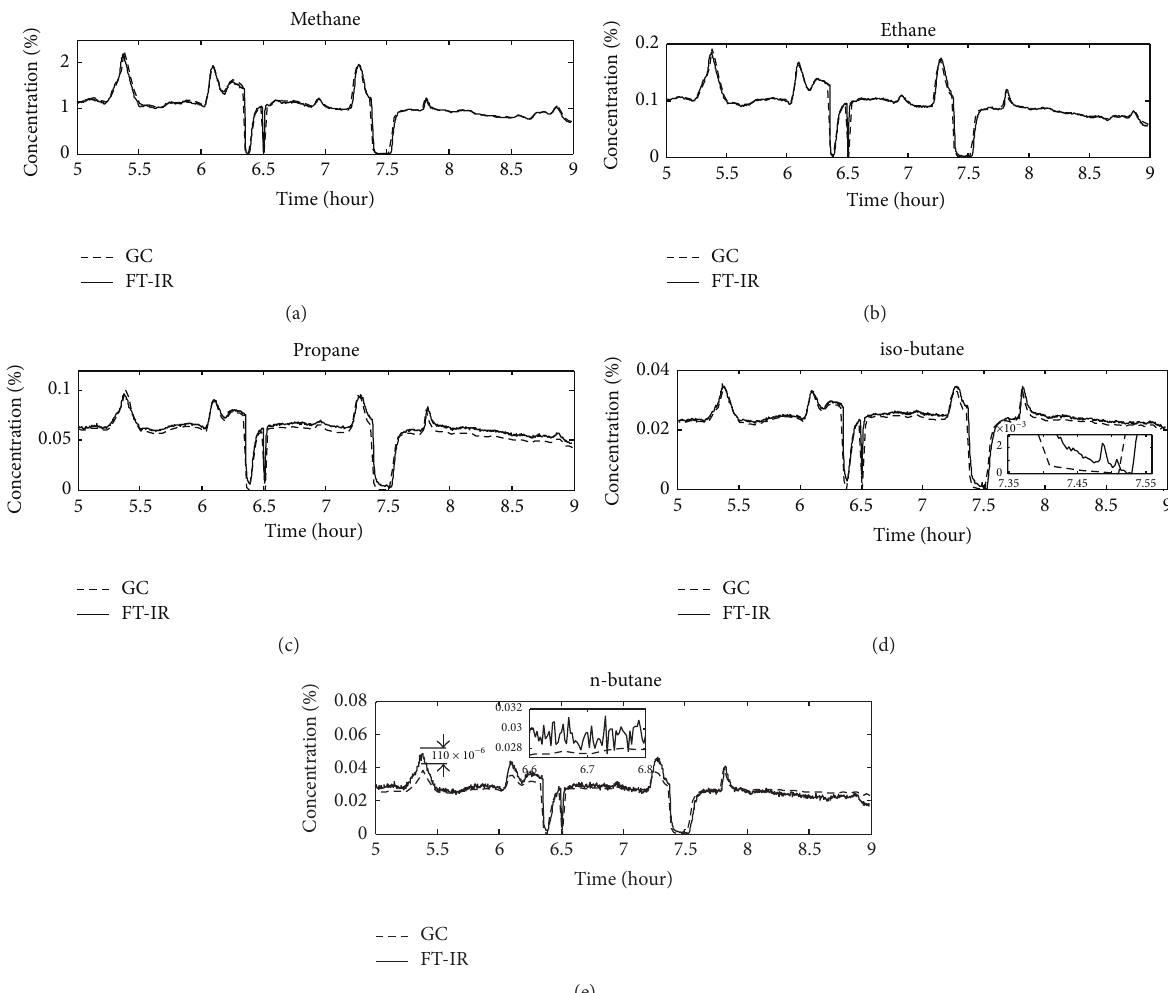
Figure 4: Analysis results obtained with FT-IR spectrometer and with gas chromatograph. (a) Methane, (b) ethane, (c) propane, (d) iso- butane, and (e)